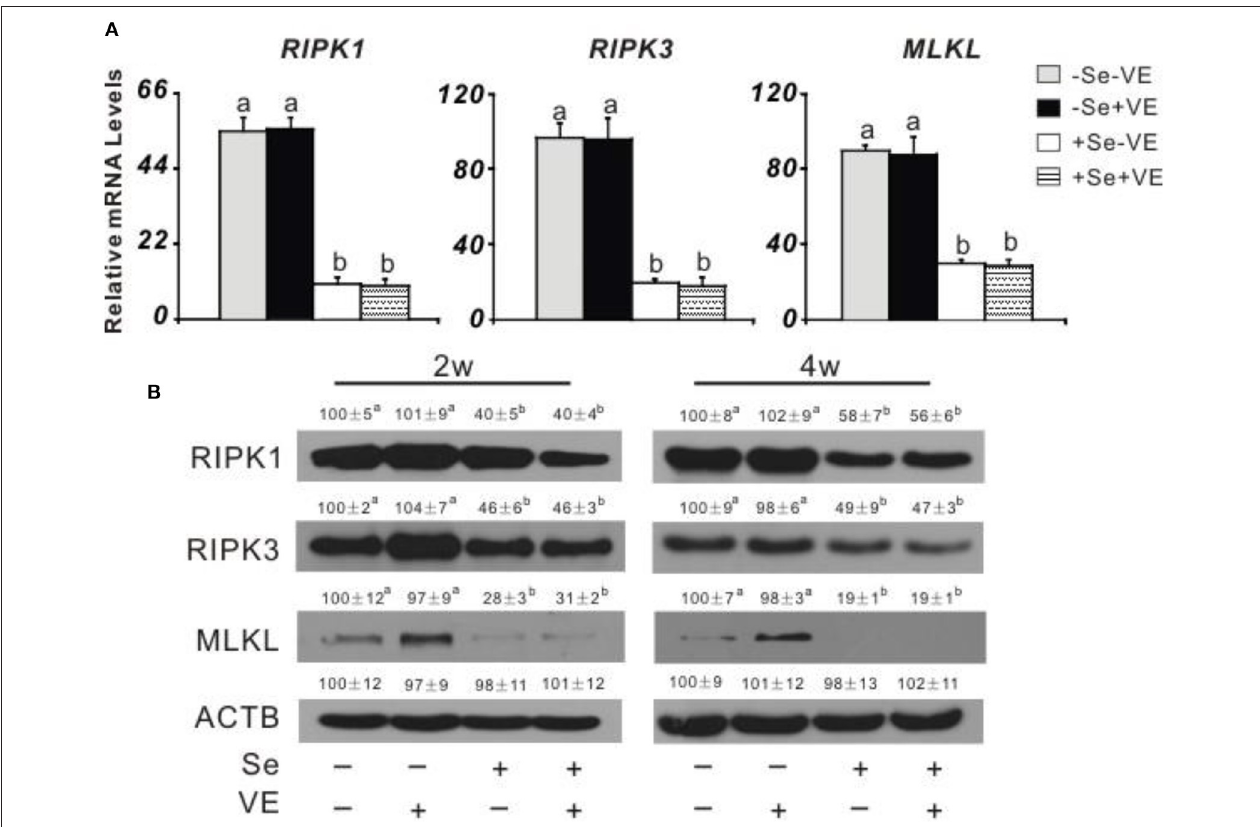
FIGURE 4 | Effects of dietary Se and VE on hepatic (A) relative mRNA abundance of receptor-interacting serine-threonine kinase 1 ( RIPK1 ), receptor-interacting serine-threonine kinase 3 ( RIPK3 ), and mixed lineage kinase domain-like ( MLKL ) in chick at week 4 and (B) protein levels of RIPK1, RIPK3, MLKL, and ACTB in chick at weeks 2 and 4. Data are means ± SE, n = 5 (A) or 3 (B) . Values within a given gene differ ( P < 0.05) without sharing a common superscript